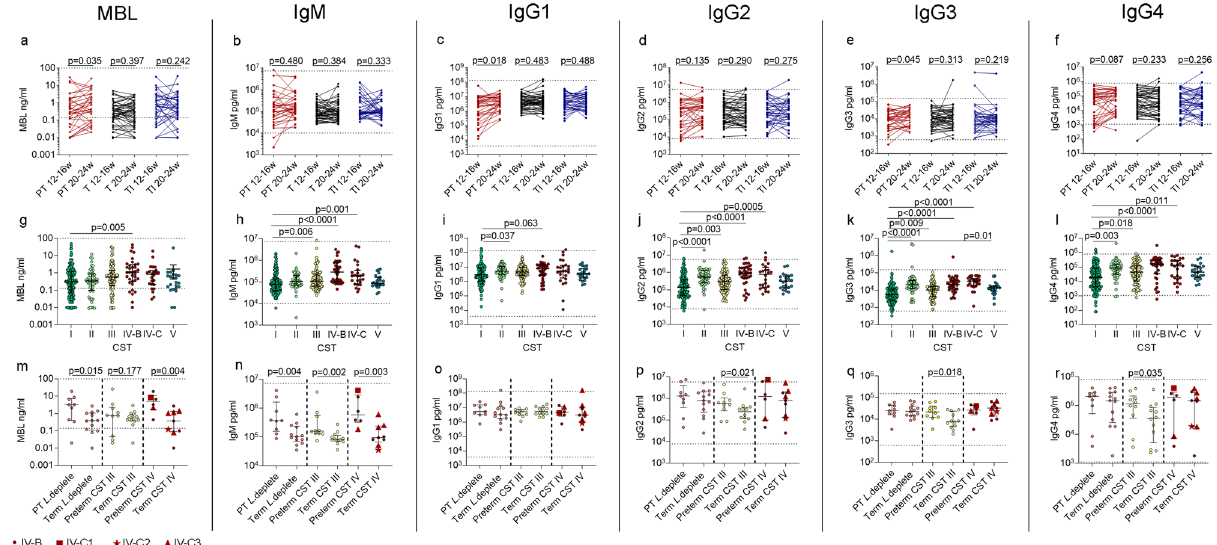
Fig. 4 Cervicovaginal concentrations of mediators of microbial recognition differ depending on vaginal microbial composition and birth outcome. Cervicovaginal concentrations of MBL, IgM, and Ig1-IgG4 were measured and concentrations compared between 12 – 16 weeks and 20 – 24 weeks in women who delivered preterm, term without intervention, and at term following intervention a – f , n = 122. Statistical analysis was performed using a